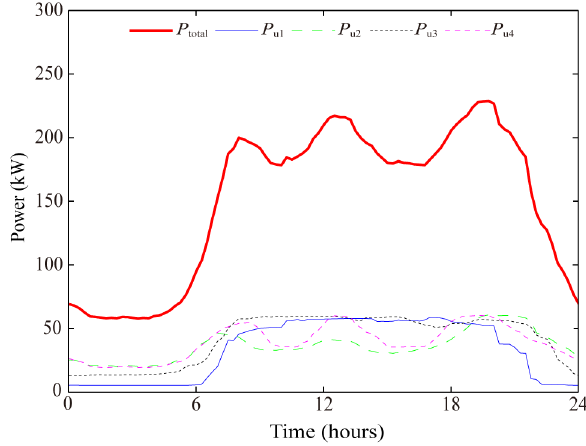
Figure 2. Forecasted load profiles of the power grid and users.